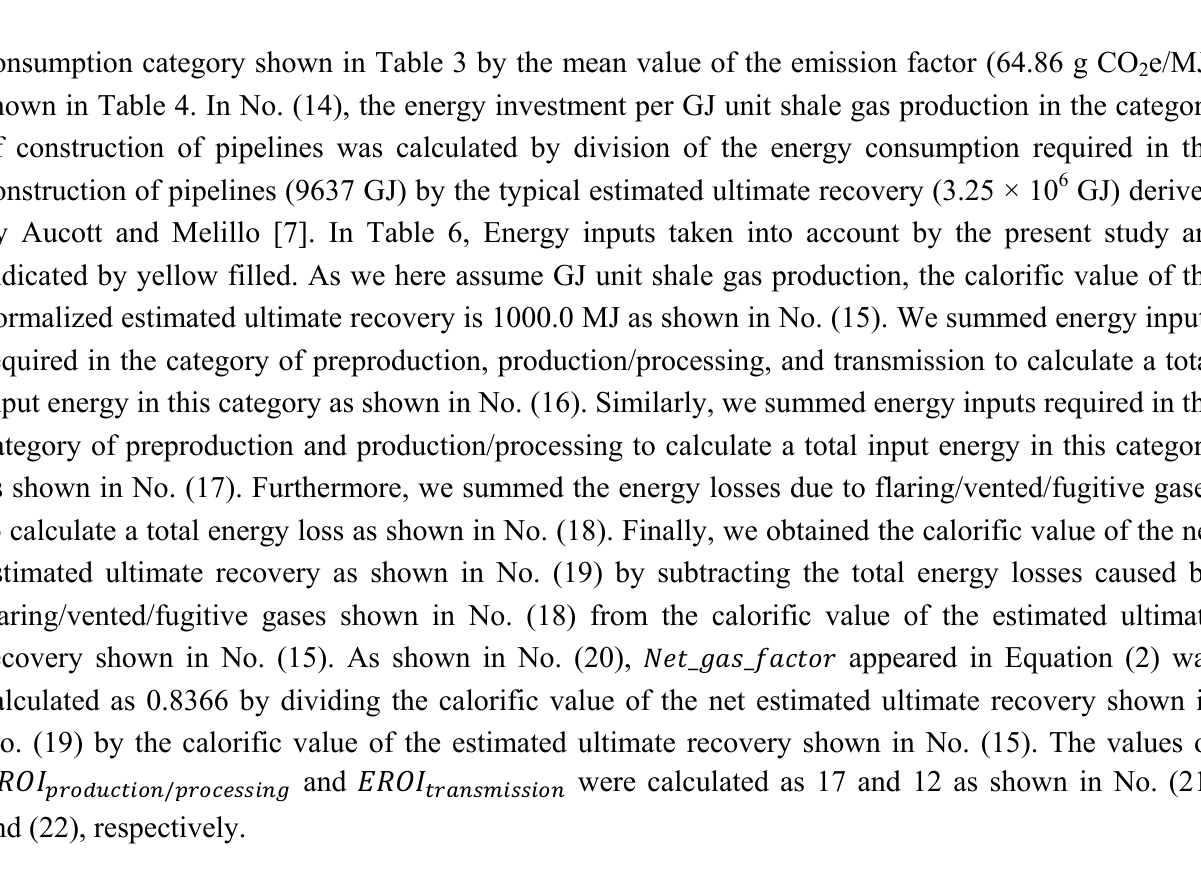
Table 6. Energy investment [MJ] per GJ unit shale gas production for each category. Energy inputs taken into account by the present study are indicated by yellow filled.